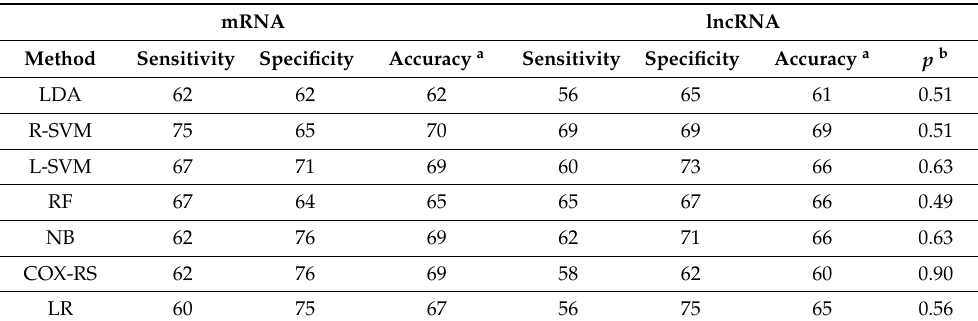
Table A3. Classification of ER positive BC patients with optimized balanced accuracy using seven individual